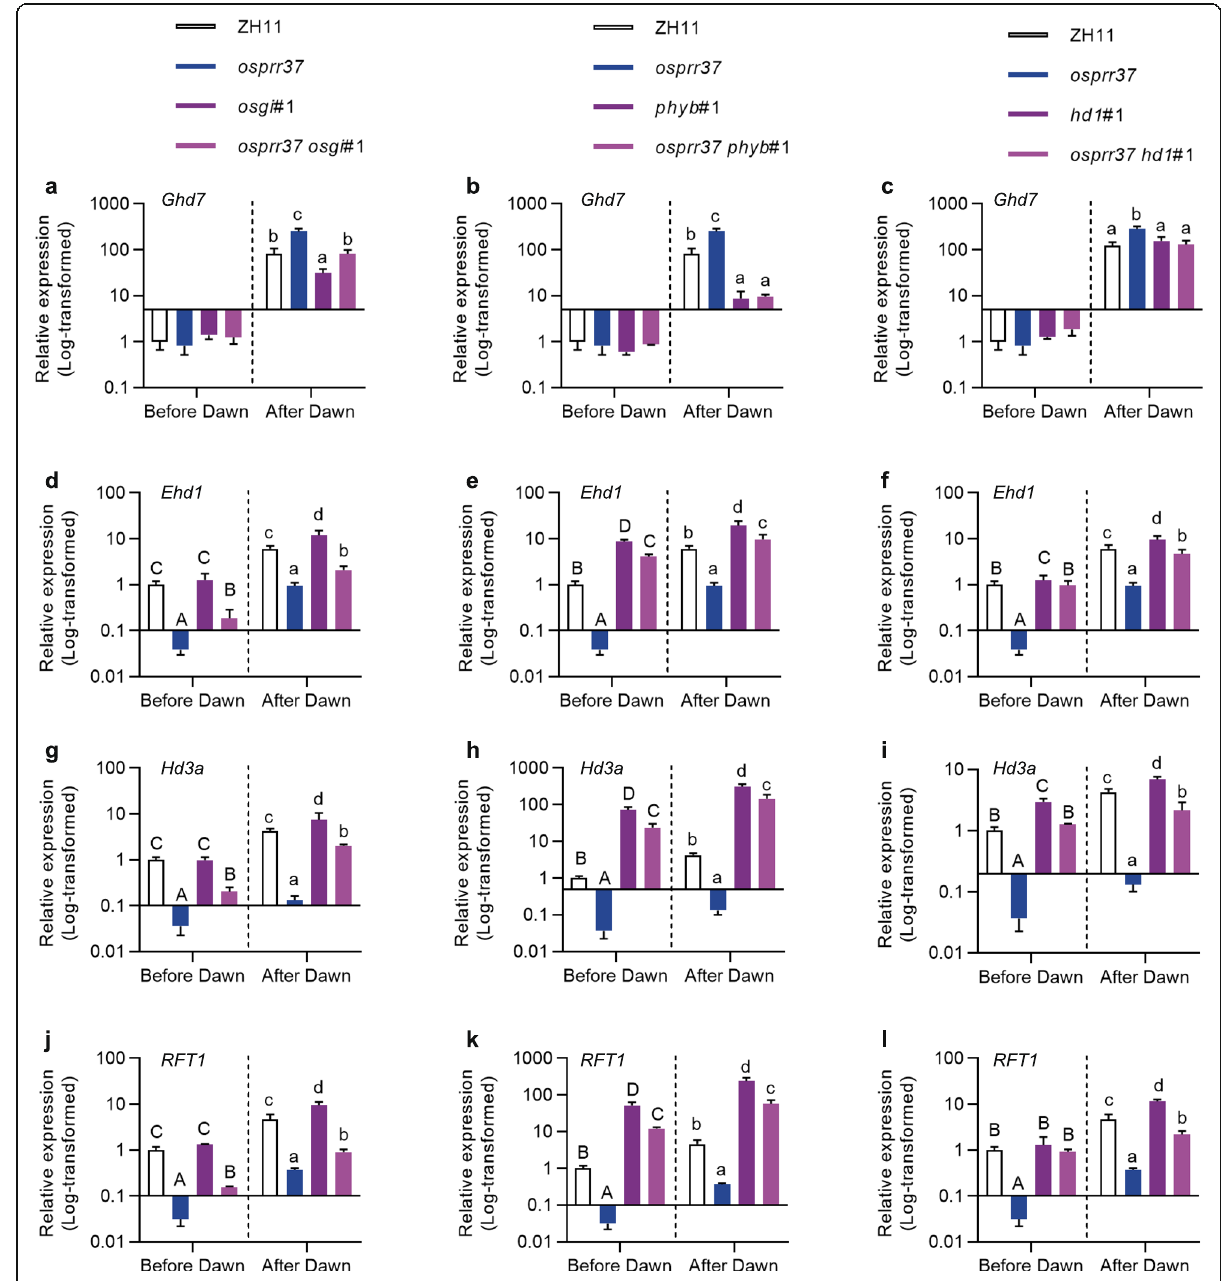
Fig. 6 Expression analysis of key flowering genes in genetic materials related to OsGI , Os PhyB and Hd1 . Log 10 -transformed expression of Ghd7 , Ehd1 , Hd3a , and RFT1 in the single mutants and double mutants of OsPRR37 and OsGI ( a, d, g and j ), OsPRR37 and PhyB ( b, e, h and k ), and OsPRR37 and Hd1 ( c, f, i and l ), respectively. Samples were collected 2.5 h before and after dawn from 40-d-old plants under controlled LD conditions. Data represent mean ± SD of three replicates. Rice ubiquitin gene (Os02g0161900) was used for normalization. Different upper- and lower-case letters indicate significant differences at P < 0.05 by using Duncan ’ s test to compare the expression levels of indicated genes before and after dawn,